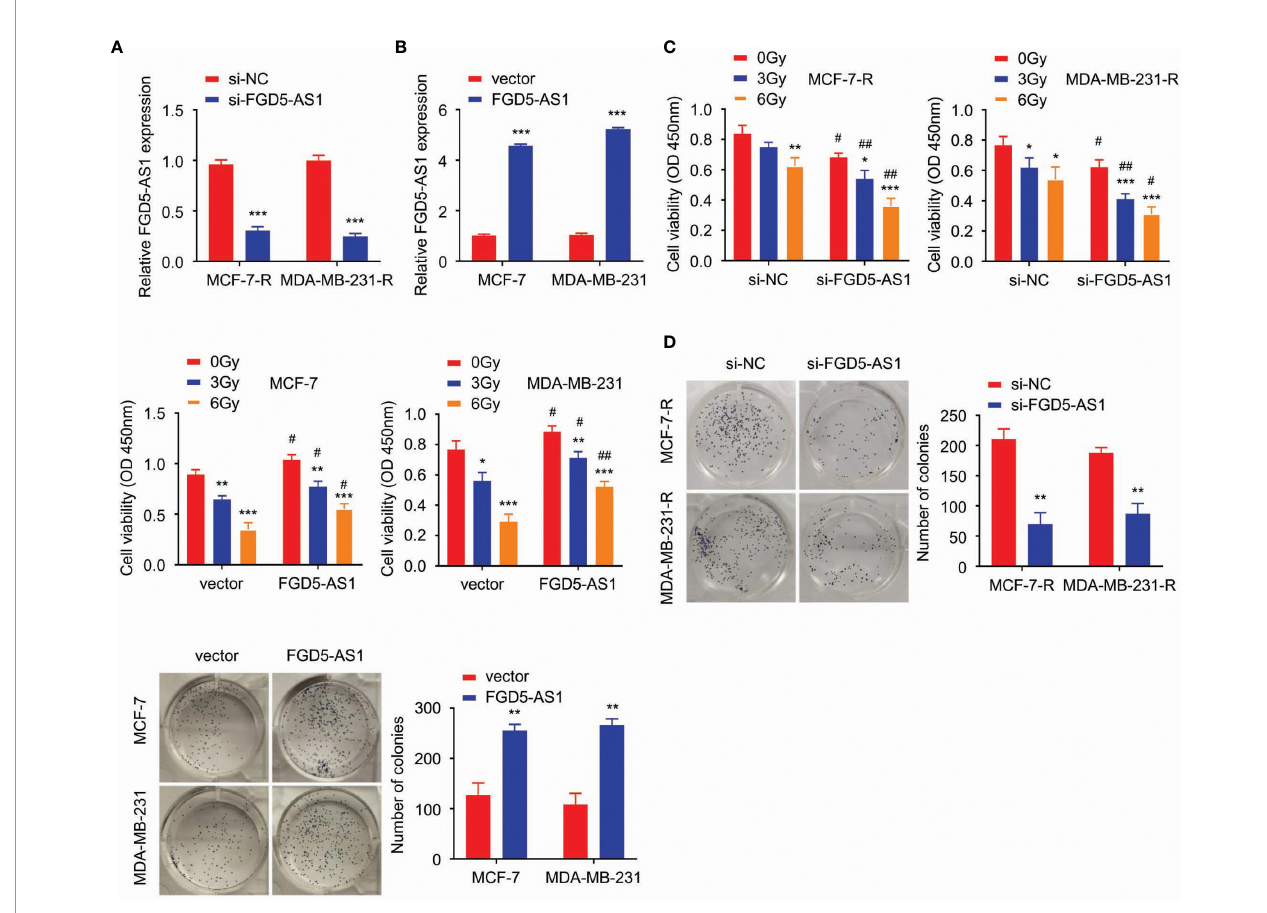
FIGURE 2 | FGD5-AS1 strengthens the radio-resistance of BC cells. (A) MCF-7-R and MDA-MB-231-R were transfected with speci fi c siRNA of human FGD5-AS1. qRT-PCR to con fi rm the downregulation of FGD5-AS1 in transfected BC cells. (B) As indicated, basing on qPCR, FGD5-AS1 exogenous expression was carried out in MCF-7 and MDA-MB-231 cells. (C) cell viability was detected by CCK-8. Cells were exposed to different doses of ionizing radiation (0, 3, and 6 Gy). FGD5-AS1 de fi ciency signi fi cantly promoted radiation sensitivity of MCF-7-R or MDA-MB-231-R cells; while FGD5-AS1 exogenous expression attenuated the radiation sensitivity of MCF-7 or MDA-MB-231 cells. (D) Colony formation assays, BC cells treated with 2 Gy ionizing radiation. Colony formation assays displayed that FGD5-AS1 de fi ciency signi fi cantly promoted radiation sensitivity of MCF-7-R or MDA-MB-231-R cells; while FGD5-AS1 exogenous expression attenuated the radiation sensitivity of MCF-7 or MDA-MB-231 cells. Intra-group comparison *p < 0.05, **p < 0.01, ***p < 0.001; Inter-group comparison # p < 0.05, ## p <